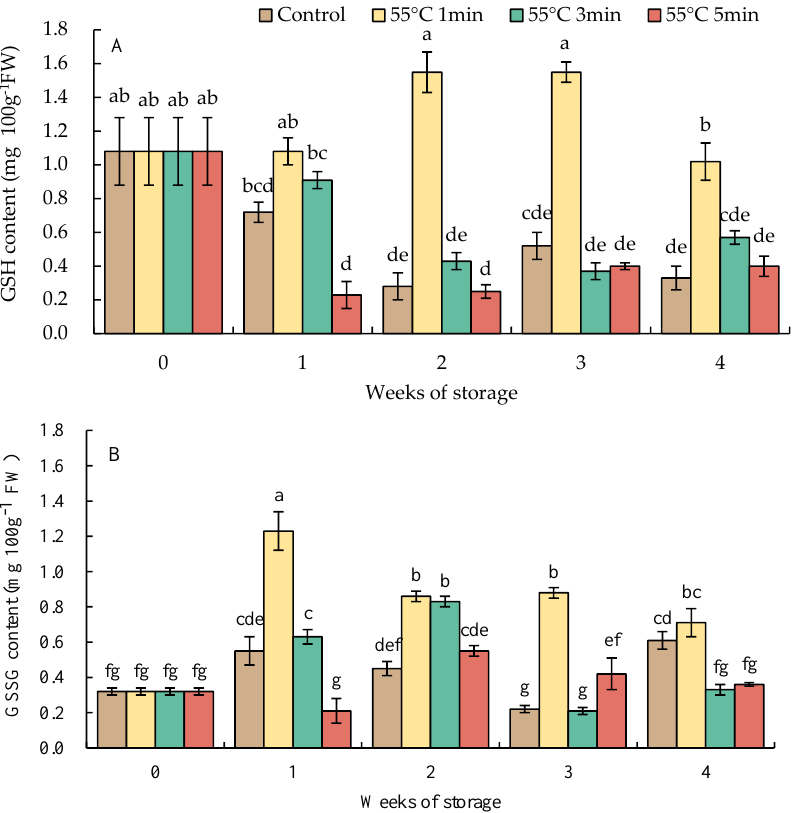
Figure 9. Effect of hot water treatment (55 ◦ C for 1, 3, 5 min) on ( A ) reduced glutathione (GSH) and ( B ) oxidized glutathione (GSSG) contents in red sweet pepper fruit during storage at 10 ◦ C. Data represent means ± S.E. (n = 3). Different letters on bars are significantly different ( p < 0.05).